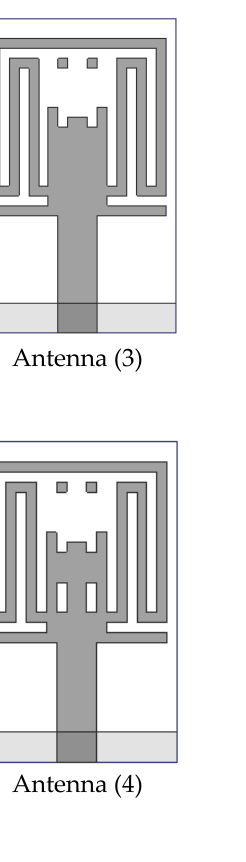
Figure 3. The step-by-step evolution process of the proposed antenna and the corresponding S 11 results at different stages. The left column gives the geometries of various antennas involved in the design evolution process. The right column gives the simulated S 11 results for the various antenna geometries. ( a ) Step 1; ( b ) Step 2; ( c ) Step 3; ( d ) Step 4.